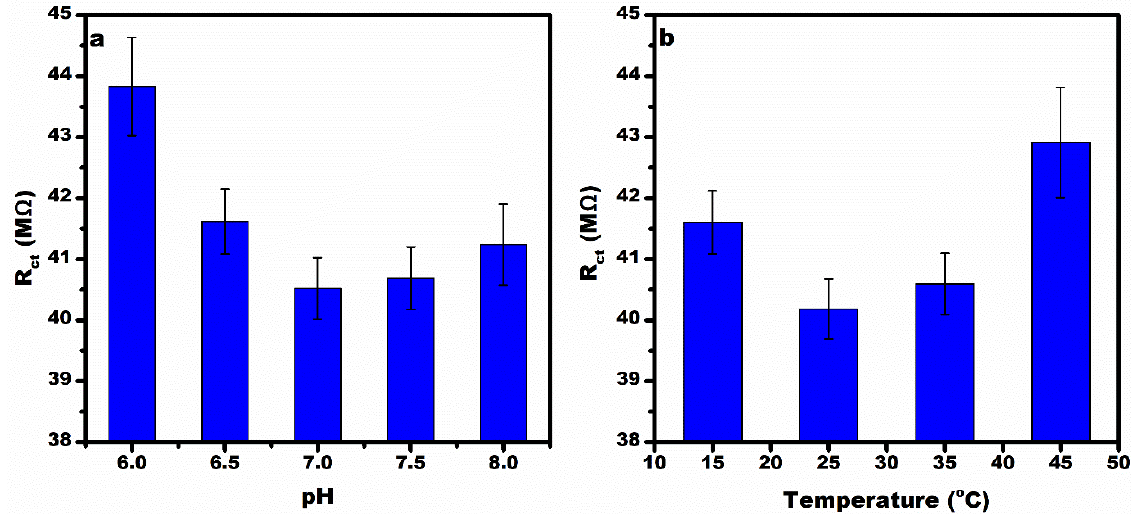
Figure 4. Effect of ( a ) pH and ( b ) temperature of anti-parathion/Au-IDE for the detection of parathion at 1 µM concentration.